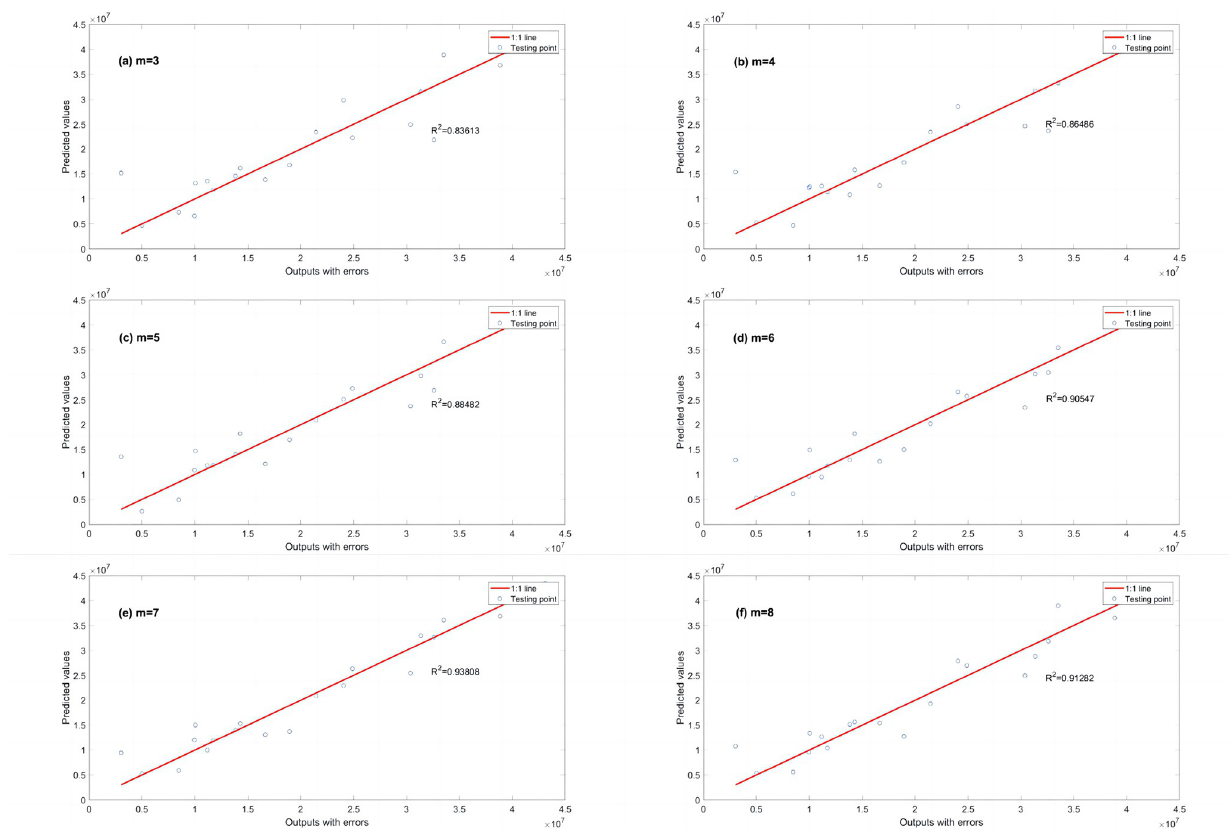
Fig 13. R 2 calculated by EPR with L2RM in dataset 3. (a) m = 3, (b) m = 4, (c) m = 5, (d) m = 6, (e) m = 7 and (f) m = 8.